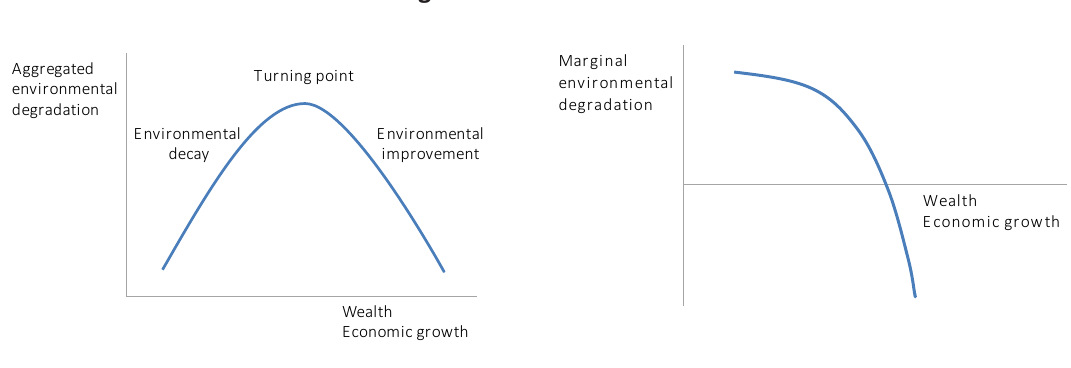
Figure 1b. Absolute EKC Figure 1. Relationship between wealth (economic growth) and environmental degradation in the